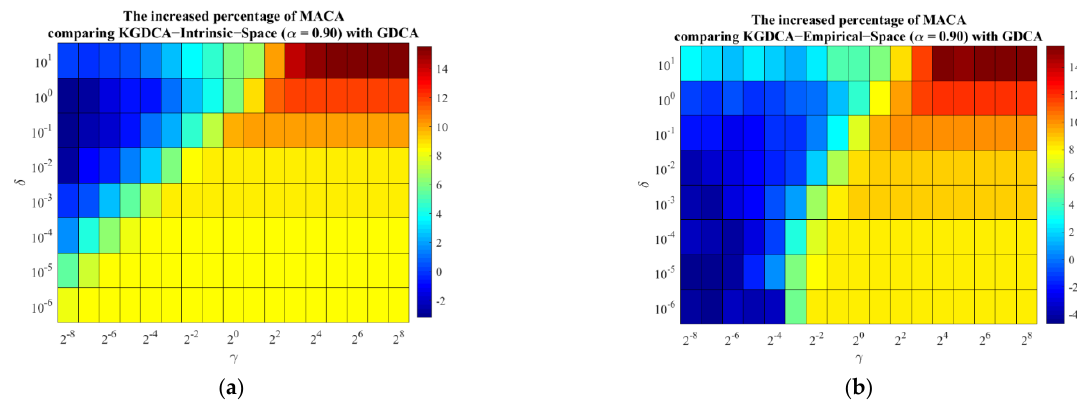
Figure 14. The increased percentages of MACA comparing GDCA’s kernelization forms driven SVM with GDCA driven